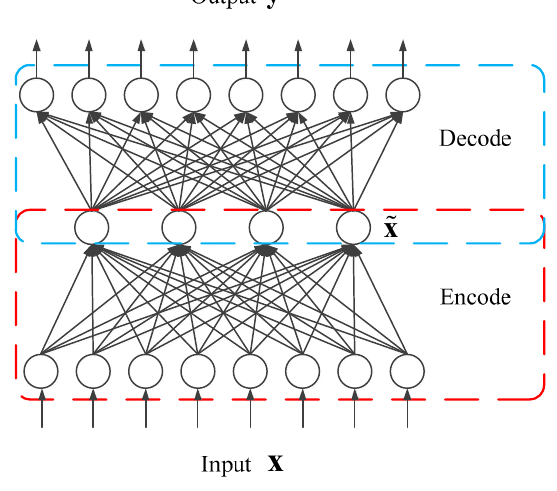
Figure 5. An autoencoder architecture.